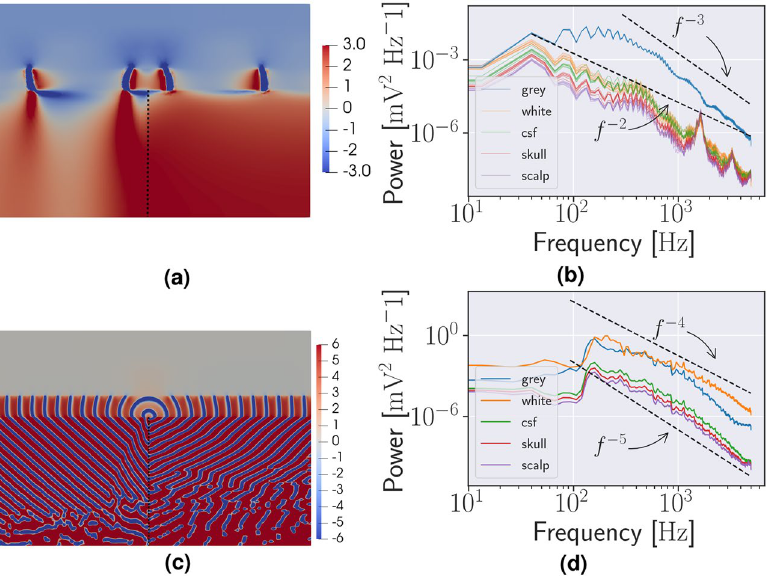
Figure 3. Two-dimensional simulations and power spectra ( a ) A snapshot of the simulated extracellular potential in Model C. The waves spread through the grey matter from the central unstable region. The unstable region is marked in Fig. 1a. ( b ) The extracellular potential in the central (unstable) grey matter. Variations to the thickness of the cerebrospinal fluid (CSF), skull and scalp as well as the individual components of the conductivity tensor by a factor of 1/3 affect the magnitude of the power spectral density (PSD) in the white matter, CSF, skull and scalp but not the grey matter. Each variation is represented by a thin line. ( c ) A snapshot of the simulated extracellular potential in Model D. Waves spread from the GM from the unstable central region, and also into the white matter. ( d ) The PSD of the extracellular potential in the different tissues with no cell model in the